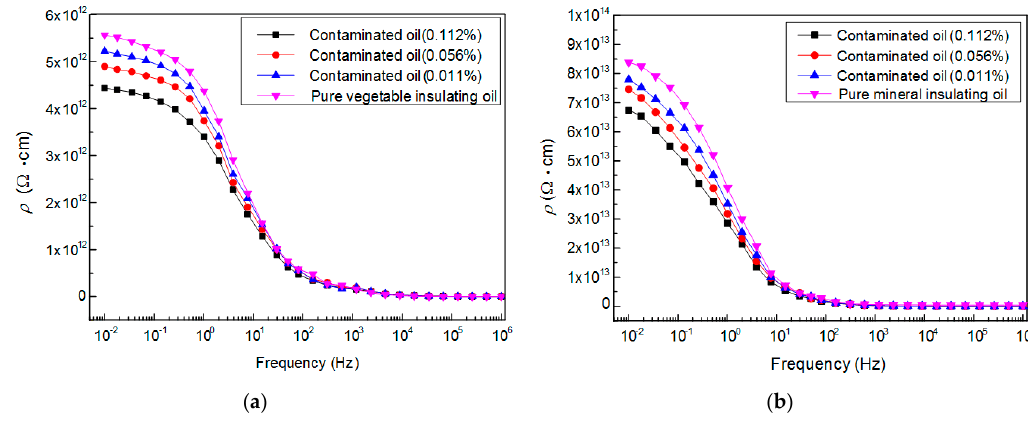
Figure 5. Volume resistivity of ( a ) vegetable insulating oil and ( b ) mineral insulating oil versus frequency with different copper volumetric concentrations.